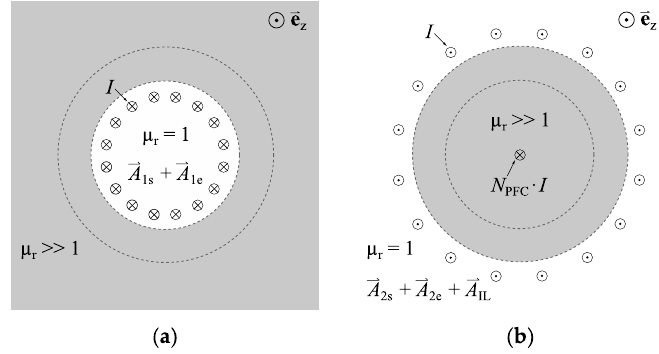
Figure 8. Two parts of the field problem to be solved for the calculation of the magnetic field: for the ( a ) inner windings and ( b ) outer windings.